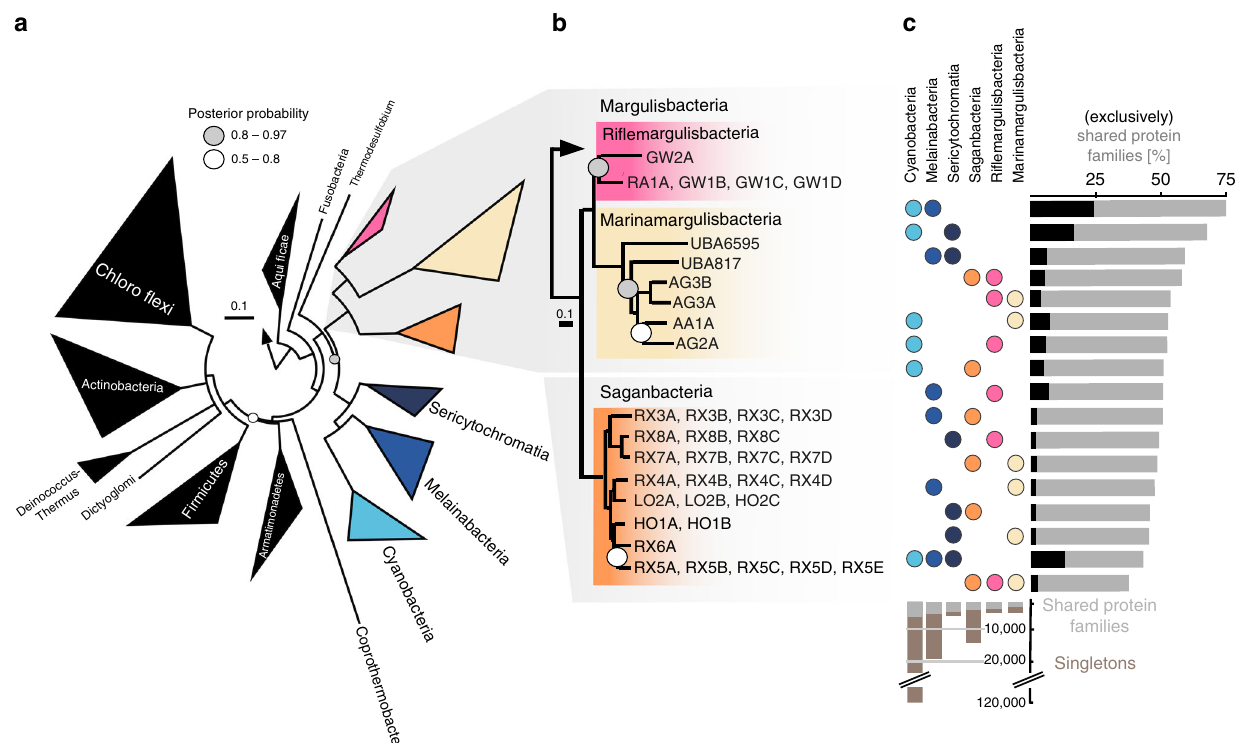
Fig. 1 Phylogenetic tree based on 56 concatenated proteins and shared protein families. a Location of Margulisbacteria and Saganbacteria in a de-replicated species tree of the Terrabacteria (detailed tree shown as Supplementary Fig. 1). b Phylogenetic relationship of members of the Margulisbacteria and Saganbacteria. See Supplementary Data 1 for genome identi fi cation details. Support values are not shown at nodes with maximal support (posterior probabilities > 0.97). c Shared protein families among lineages: rows cover the total number of protein families shared among lineages and dots indicate which lineages are being compared. For example, the top bar indicates that in average 75% of protein families are shared between Cyanobacteria and Melainabacteria, out of which 25% are exclusively shared between them. The other 50% includes proteins that are shared with at least one other lineage. At the bottom, bars show for each lineage the total number of singletons (unique to respective lineage) in brown, and the number of protein families that is shared with one or more lineages in gray. One hundred percent shared represents the union of all the non-singleton families of the two lineages under comparison. For details on taxon sampling, tree inference and shared protein families, see Methods